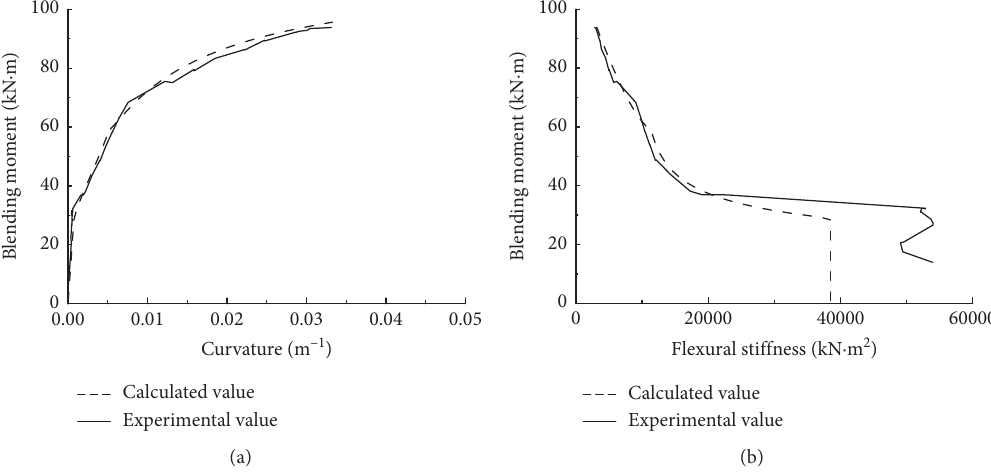
Figure 15: Beam B-1-30-4. (a) Bending moment-curvature curve. (b) Bending moment-stiffness curve.